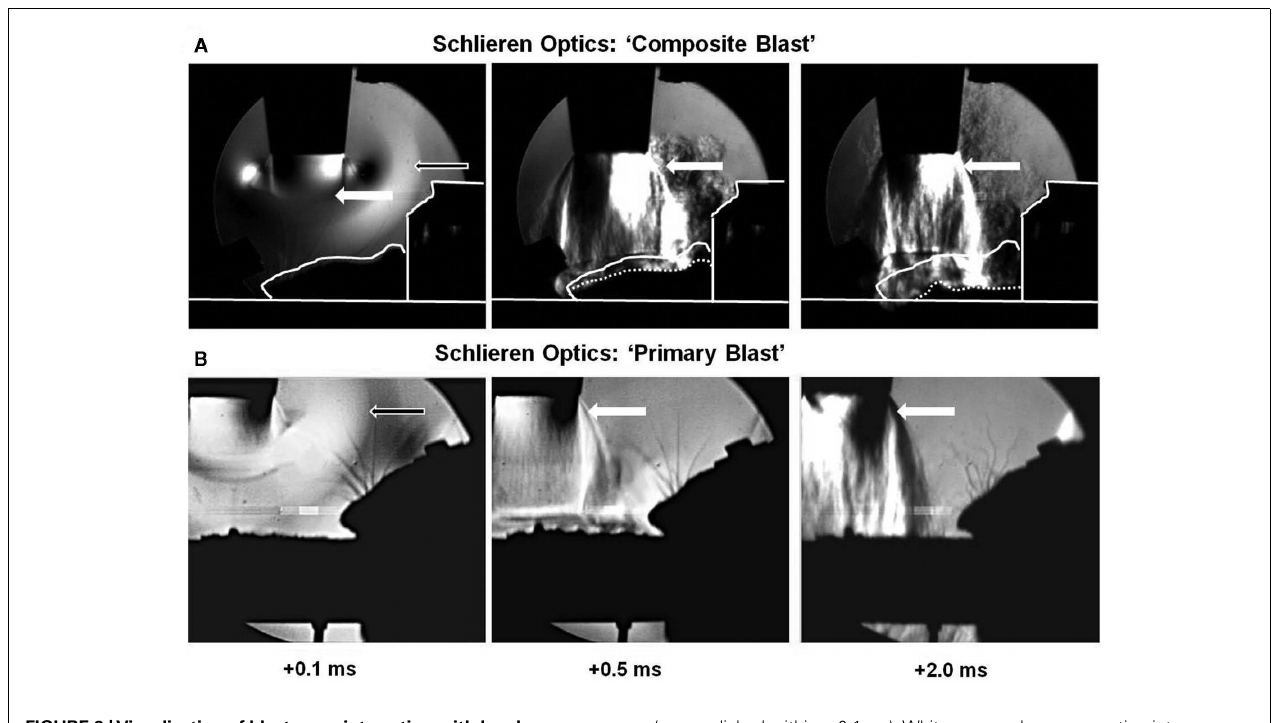
FIGURE 2 |Visualization of blast wave interaction with head on-axis (“composite” blast) and off-axis (primary blast) using Schlieren optics. High speed recording with Schlieren optics: (A) “composite blast”; (B) “primary blast.” Black arrows indicate formation, traveling, and interaction of blast wave with rat head